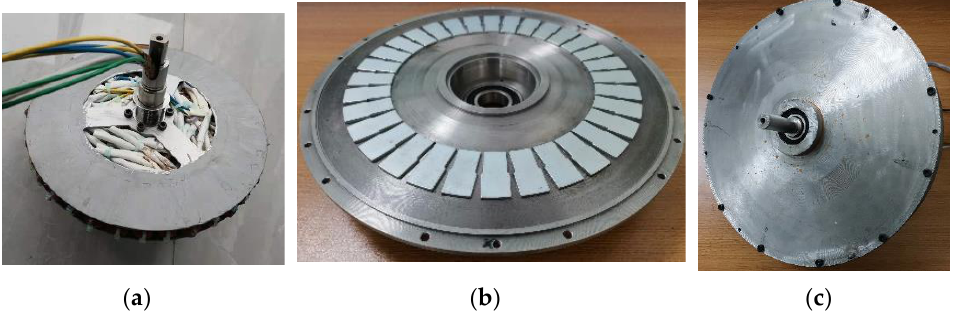
Figure 18. YASA machine assembly: ( a ) stator; ( b ) rotor; ( c ) machine assembly.